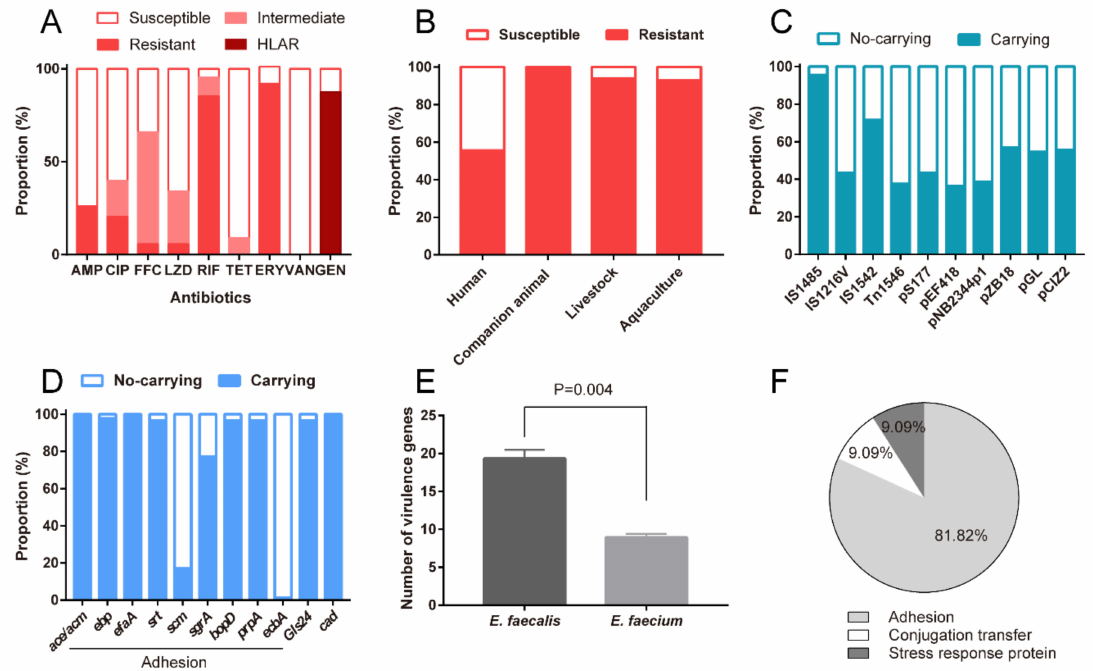
Figure 3. Risks of probiotic enterococcal isolates. ( A ) Resistance rates of probiotic enterococcal isolates to different antimicrobial drugs. ( B ) Resistance rates of probiotic enterococcal isolates used for different application targets. ( C ) Carrying rates of different mobile genetic elements. ( D ) Carrying rates of different virulence genes. ( E ) The number of virulence genes in E. faecalis and E. faecium isolates. ( F ) Different functions of virulence genes in these probiotic enterococcal isolates. Differences in E were statistically analyzed by Student’s t -test. p ≤ 0.05 was considered to be